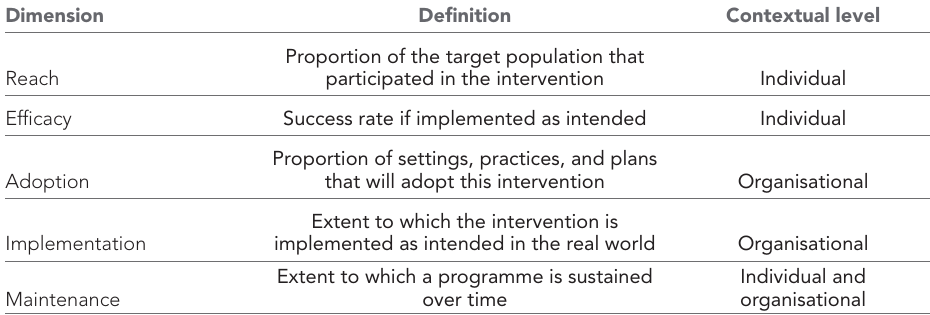
Table 1 RE- AIM framework